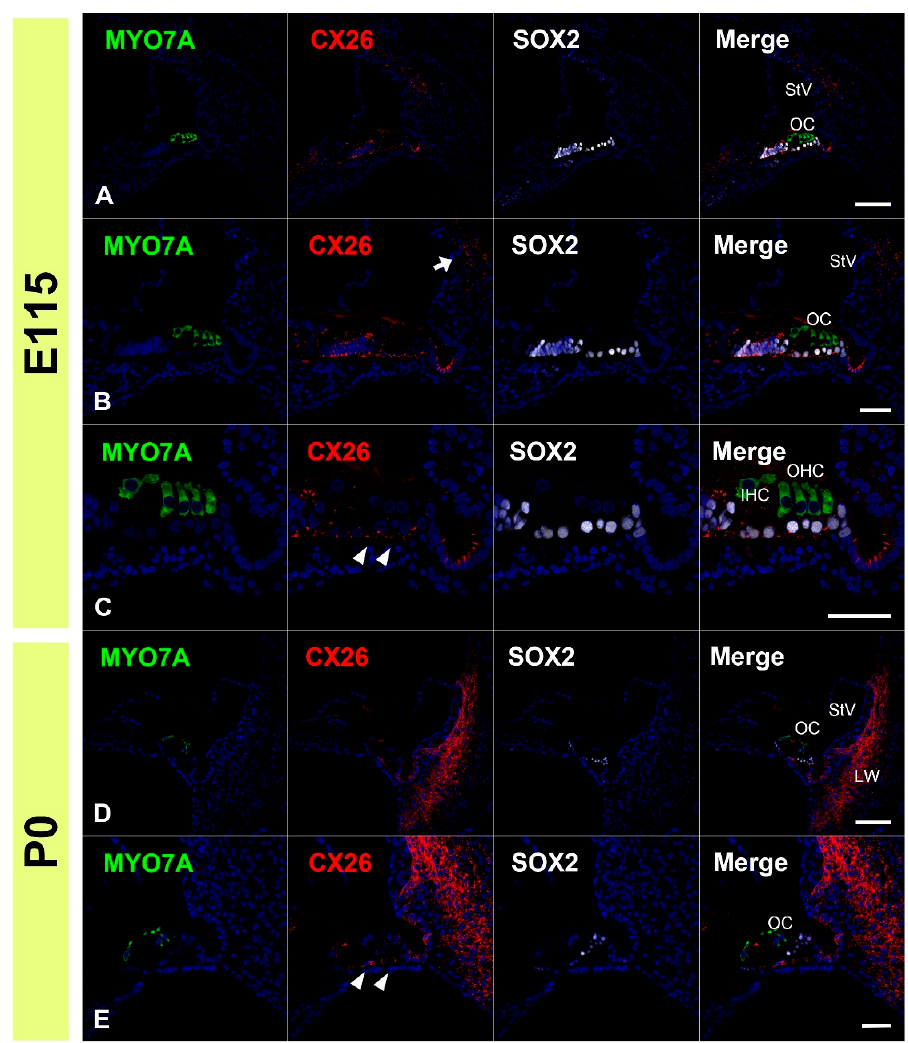
Figure 2. Changes in the expression patterns of CX26 at E115 and P0. ( A – C ) At E115, a broader expression of CX26 was detected in the sensory epithelium, including in the SOX2-positive supporting cells. However, no expression was observed in the MYO7A-positive hair cells. Weak expression was also observed in the spiral ligament fibrocytes next to the stria vascularis (arrow in ( B )). At this stage, CX26 expression in the supporting cells was observed only near the basal-side membrane (arrowhead in ( C )). ( D , E ) At P0, strong CX26 expression was observed in spiral ligament fibrocytes, while relatively weak expression was observed in the organ of Corti (arrowhead in ( E )). Nuclei were counterstained with Hoechst stain (blue). Scale bar: 100 µm in ( A , D ), 50 µm in ( B , C , E ). OC: organ of Corti, IHC, inner hair cells; OHC, outer hair cells, StV: stria vascularis, LW: lateral wall fibrocytes, ( A – E ): basal turn.